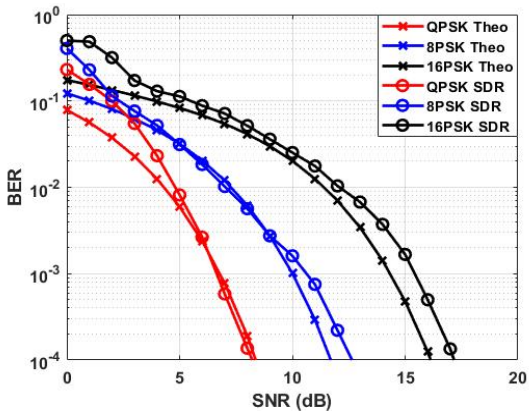
Figure 12. BER comparison between theoretical values and SDR performance.